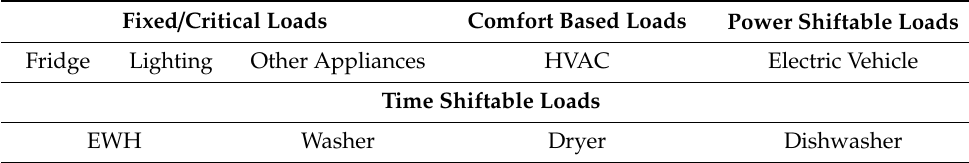
Table 1. Residential appliances